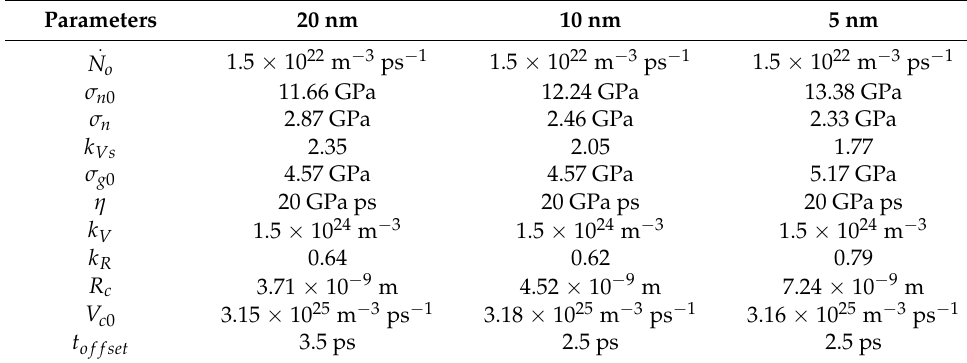
Table 3. Fitted MNAG parameters for nanocrystalline